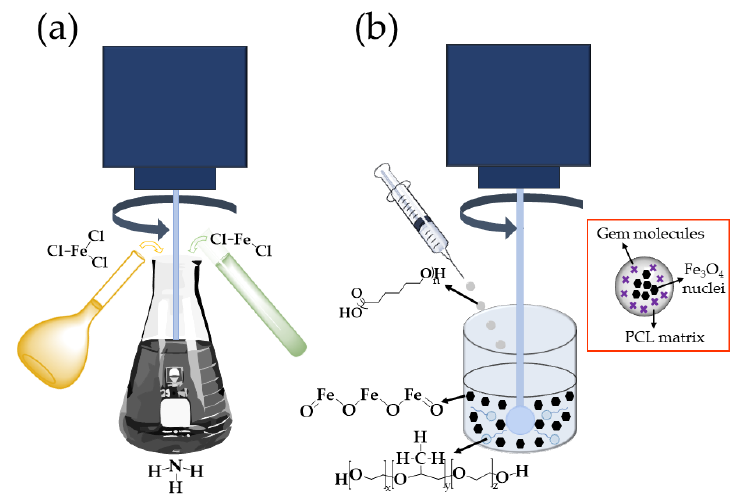
Figure 1. ( a ) Chemical co-precipitation to prepare Fe 3 O 4 nanoparticle (NPs) [32], and, ( b ) formulation of the core / shell NPs by interfacial polymer disposition [25,27]. Inset: structure of the Gemcitabine (Gem)-loaded Fe 3 O 4 /poly( ε -caprolactone) (PCL) (core/shell) NPs.